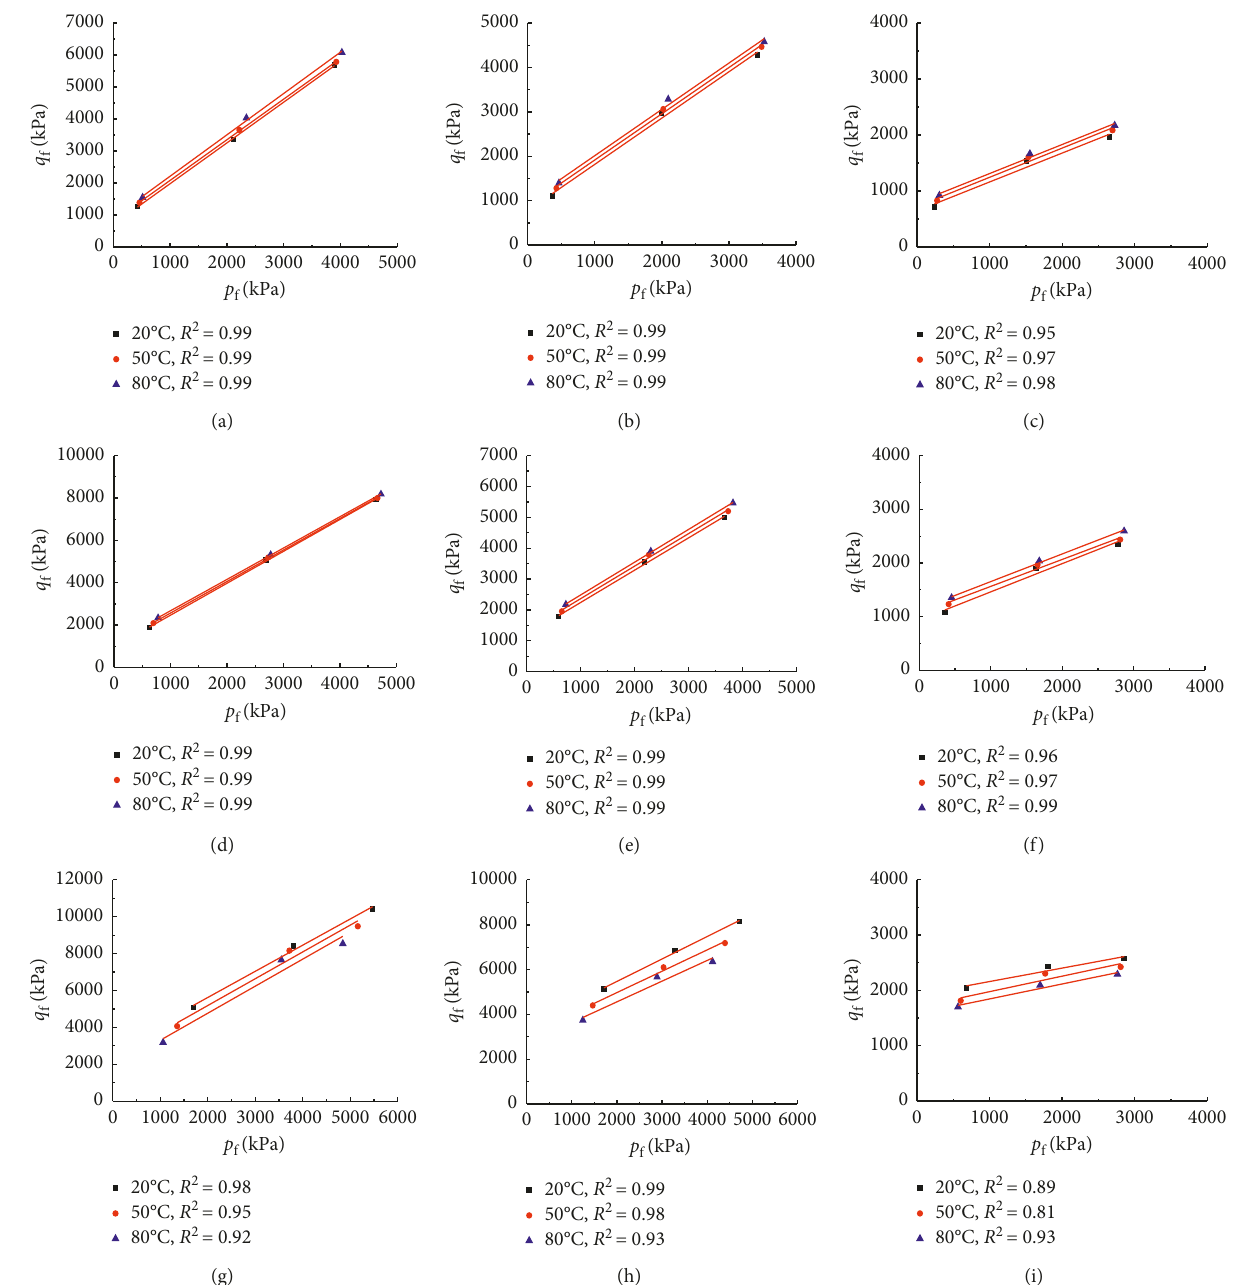
Figure 7: The strength envelope on the p 1.4g/cm 3 , w � 5%. (b) ρ 1.6g/cm 3 , w � 25%. (g) ρ